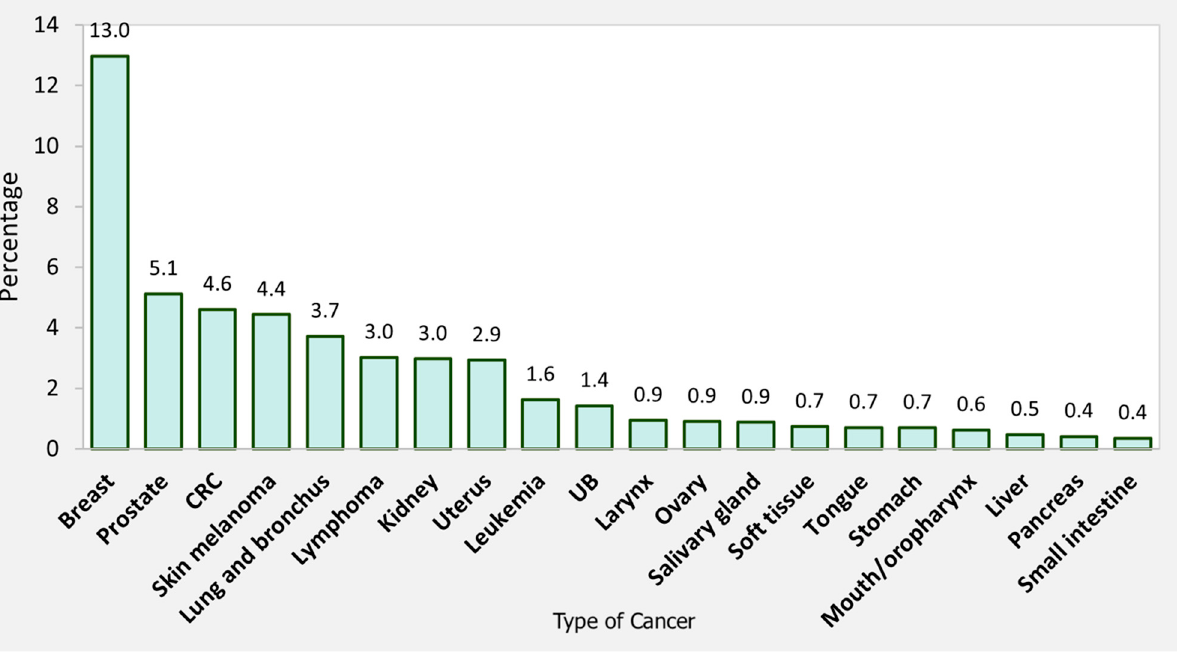
Figure 2. Type of primary cancer as a percentage of patients with primary malignancy developing subsequent thyroid cancer. UB: Urinary and bladder cancer, CRC: Colorectal cancer.